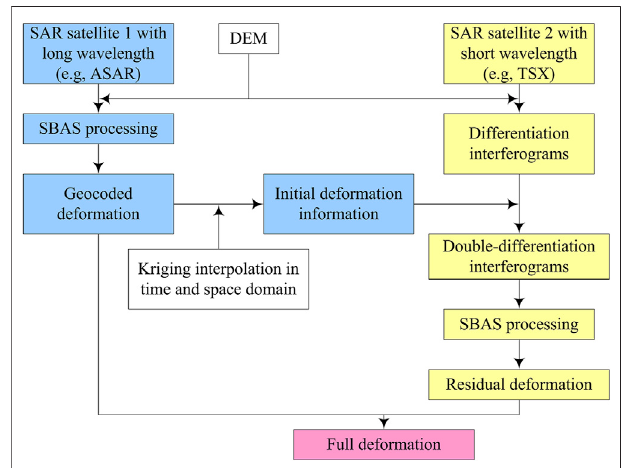
FIGURE 1 | Flowchart of the implemented